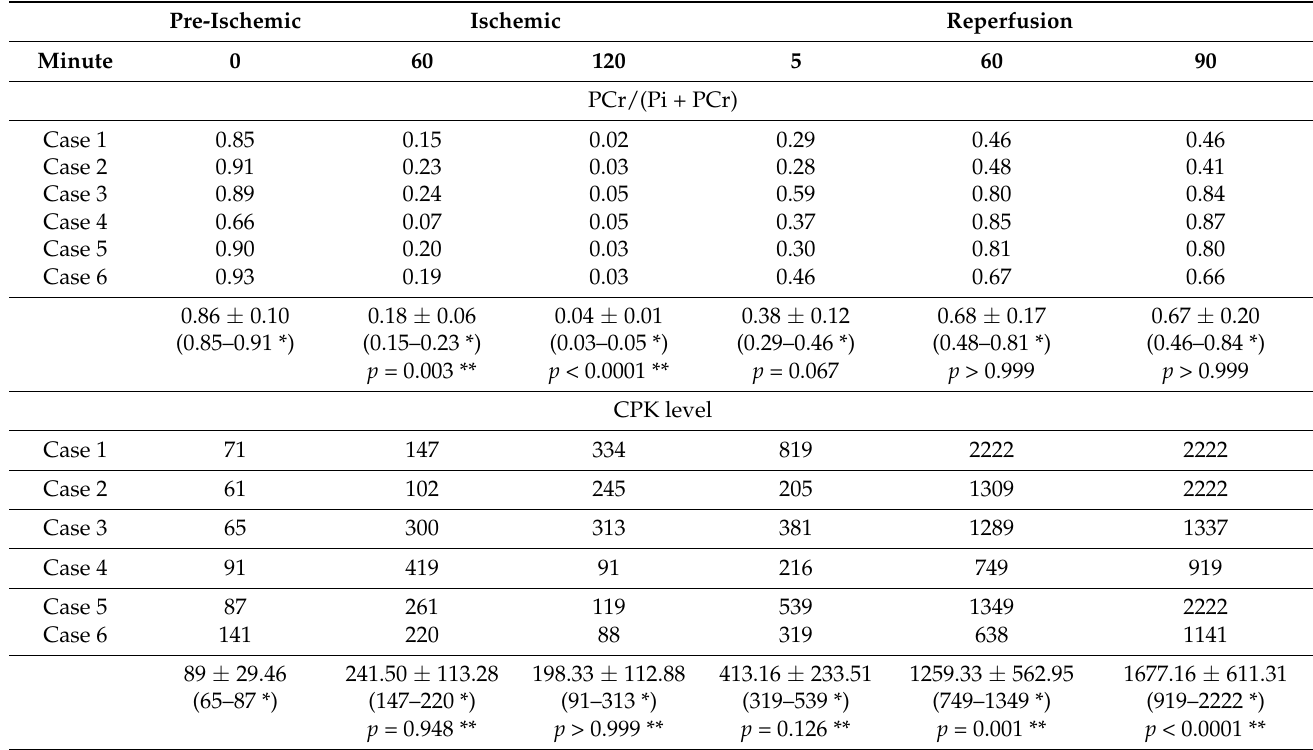
Table 1. PCr/(Pi + PCr) ratio and creatine phosphokinase (CPK) level at different time points.